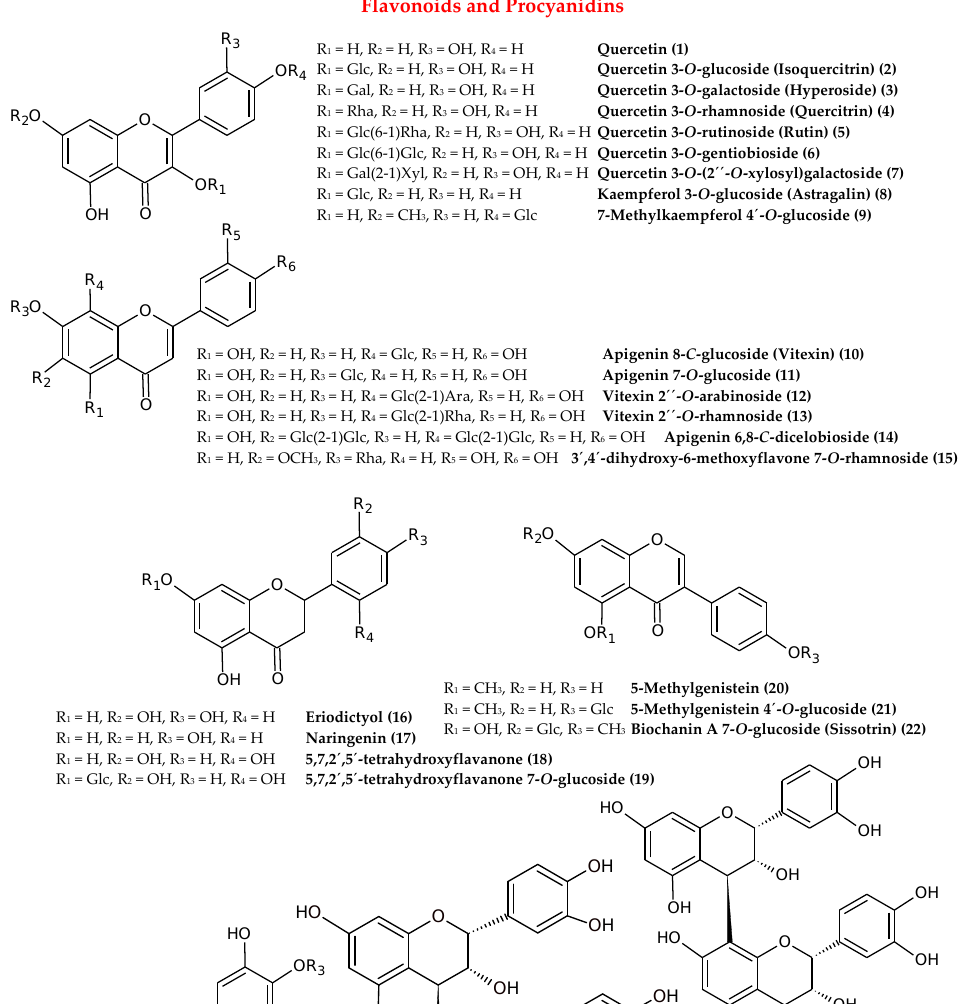
4 of 23 leaves of C. bullatus and C. zabelii (FC: 154.3 and 124.9 mg GAE/g). These leaf samples were classified as polyphenol-rich plant material, with a level comparable to or even higher than those observed for other polyphenol abundant Rosaceae leaves, i.e., Rosa canina , Aronia melanocarpa and Ribes nigrum